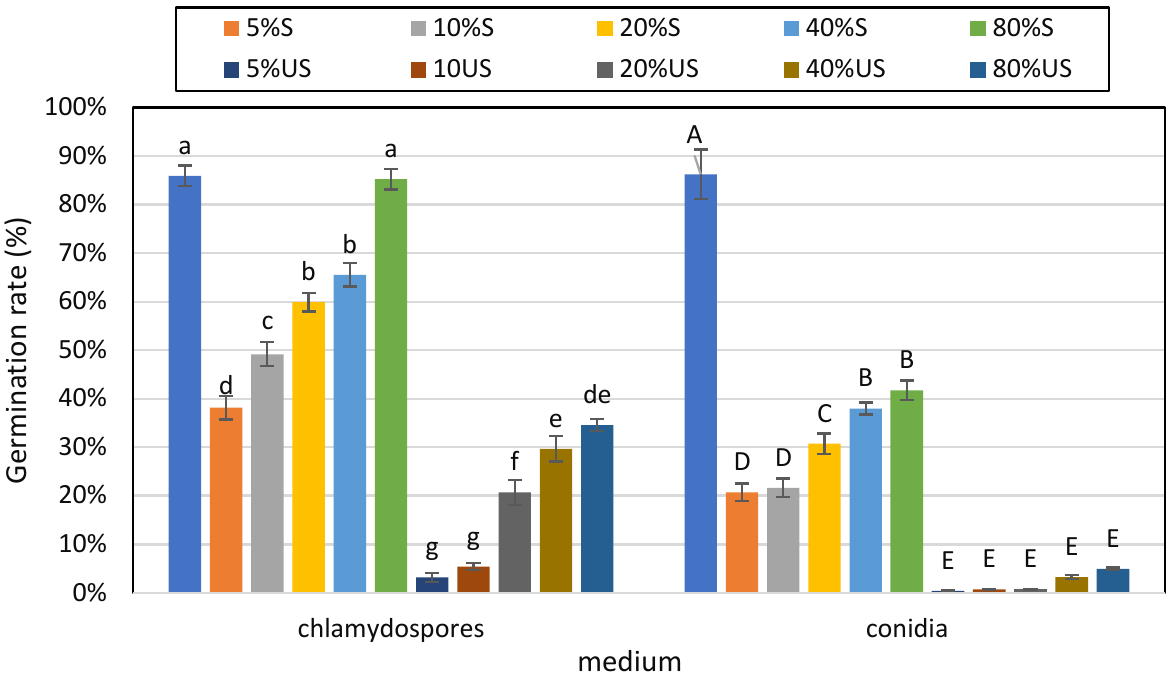
Figure 1. Germination rates of conidia and chlamydospores of Trichoderma longibrachiatum Tr58 in sterilized and unsterilized soils with different moisture levels. Lowercase letters and uppercase letters respectively indicate the significant differences of germination rates of chlamydospores and conidia in different mediums, the same letter above the column indicates no significant difference at p < 0.05. CK: PDA medium; US: unsterilized soil; S: sterilized soil, 5%,10%,20%,40%,80%: soil moistures.